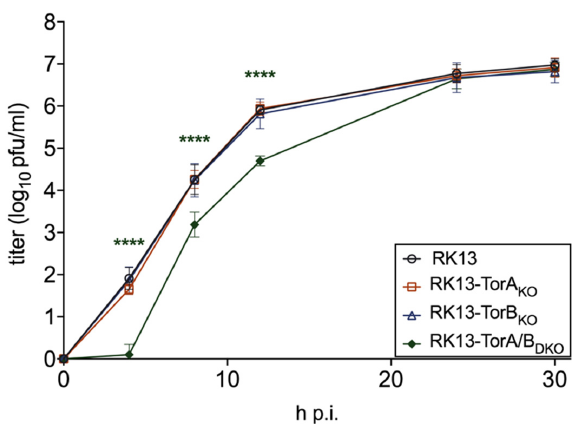
Figure 8. Effect of gene knockout on PrV replication. RK13 and Torsin KO cell lines were infected with PrV-Ka (MOI of 5) and harvested at different time points after infection. Progeny virus titers were determined on RK13 cells. Shown are mean values of six independent experiments. Statistics were done with GraphPad Prism software and asterisks indicate statistically significant di ff erences compared to the parental RK13 in the same color as the corresponding graph (****, p ≤